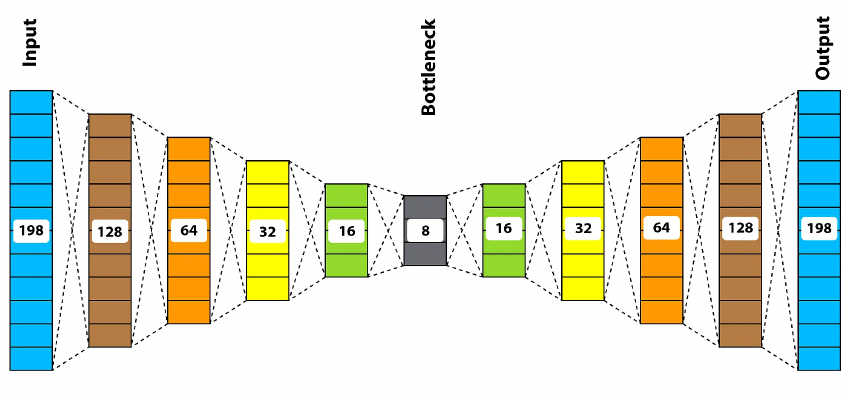
Figure 3. The proposed deep stacked